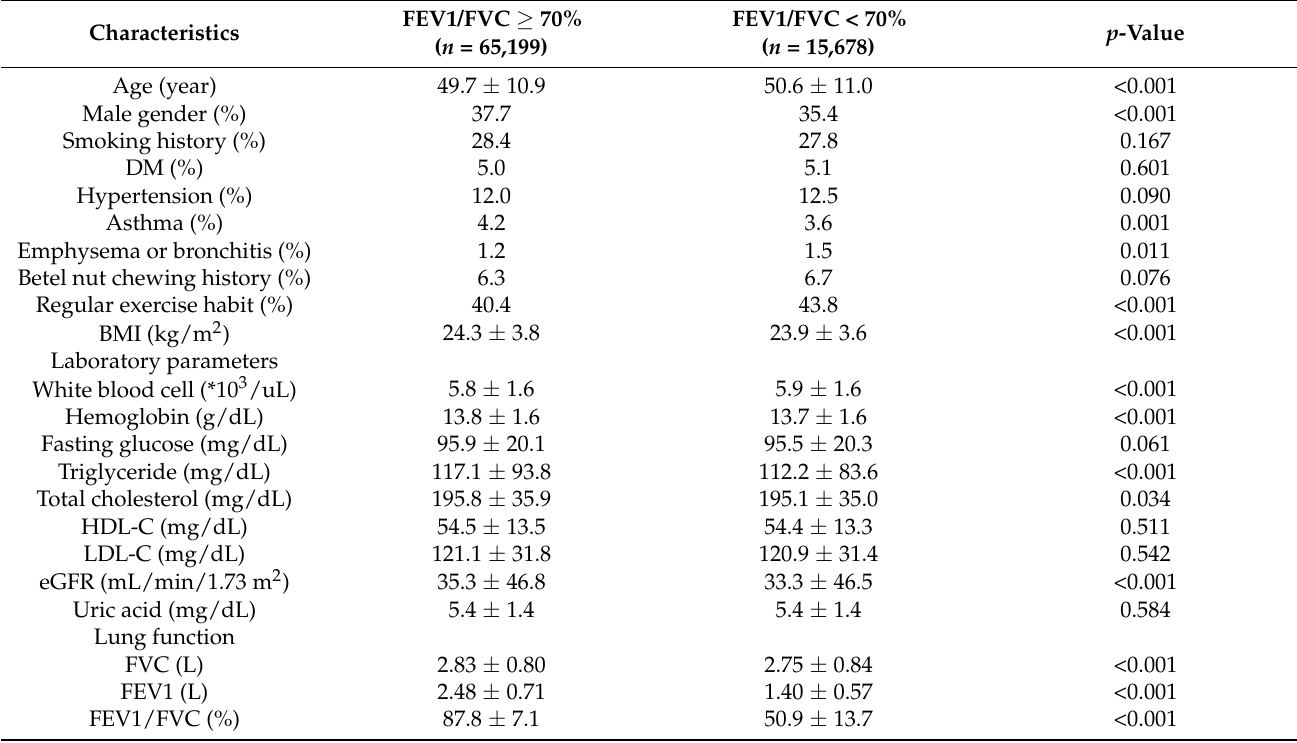
Table 1. Comparison of clinical characteristics among participants according to FEV1/FVC ≥ 70% or <70%.